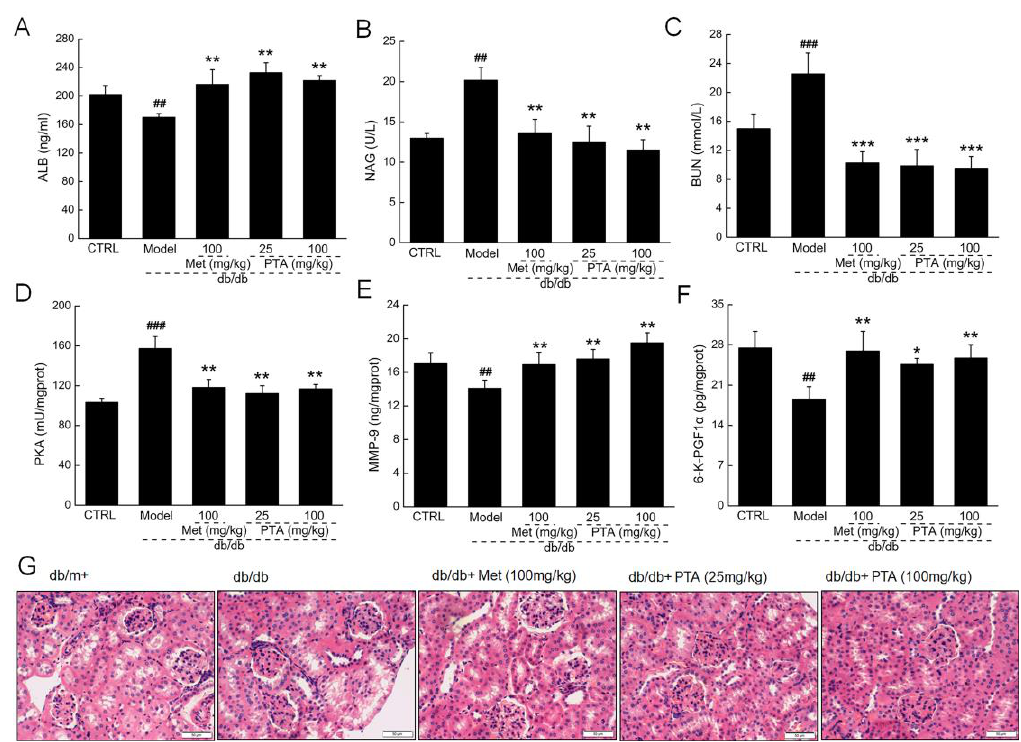
Figure 4. Renal-protective e ff ects of PTA in db / db mice after eight-week administration. PTA enhanced the levels of ( A ) albumin (ALB) and reduced the levels of ( B ) N-acetyl- β -D-glucosidase (NAG) and ( C ) blood urea nitrogen (BUN) in sera of db / db mice. PTA reduced the levels of ( D ) cAMP-dependent protein kinase (PKA) and enhanced the levels of ( E ) matrix metalloproteinase-9 (MMP-9) and ( F ) 6-keto prostaglandin F 1 α (6-K-PGF1 α ) in kidneys of db / db mice. Data are expressed as means ± SD (n = 12). ## p < 0.01 and ### p < 0.001 vs. db / m + mice, * p < 0.05, ** p < 0.01 and *** p < 0.001 vs. non-treated db / db mice. ( G ) Histopathological analysis of kidney via H and E staining (scale bar: 50 µ m) (magnification: 200 × ) (n = 6).